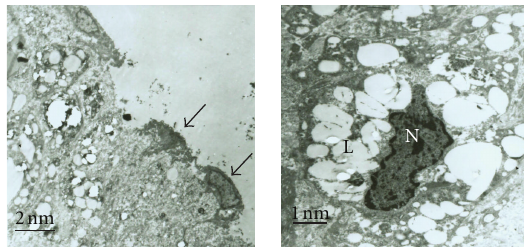
Figure 5: Transmission electron microscopic analysis and the evaluation of lesional inflammation. Damaged endothelial layer (left) and remaining endothelial cells (arrows) at 16 weeks and lipids overladen macrophages (right; L = lipid drop, N = nucleus) at 28